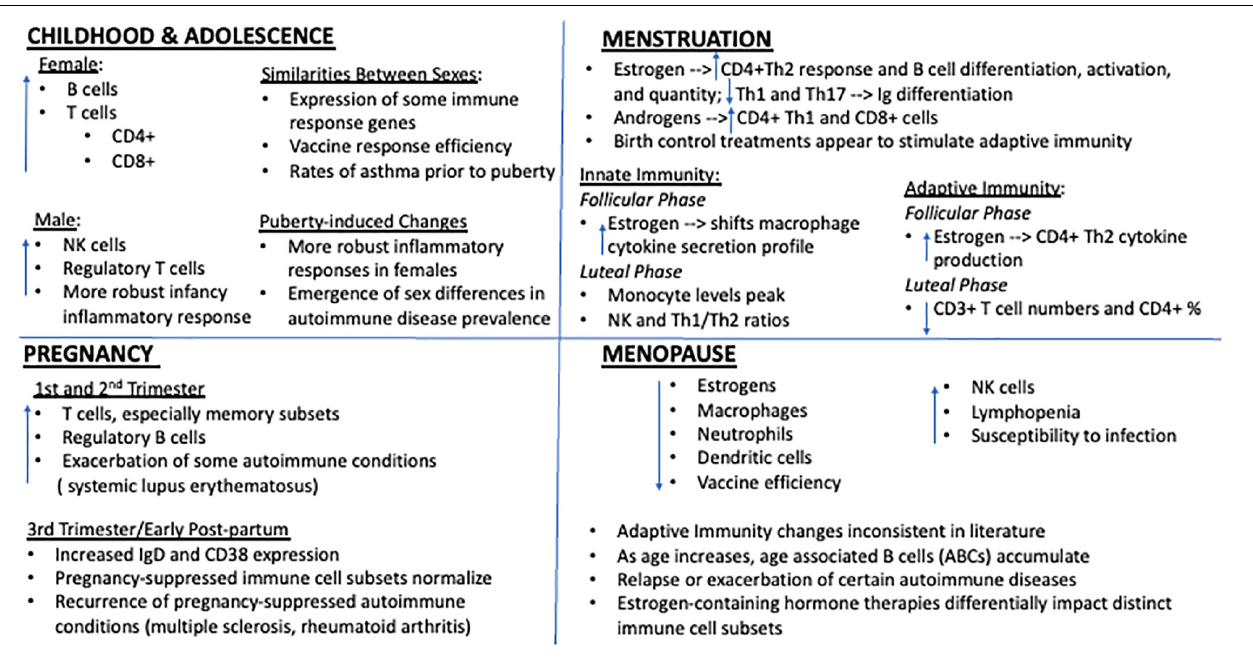
FIGURE 1 | Key immune system impacts of estrogen at distinct female reproductive milestones. Immune function is profoundly impacted by genetic sex and variations in estrogen. Though a few subtle differences have been reported during childhood, prior to puberty onset immune cell counts are generally similar between males and females and any differences appear to have little functional impact on overall immunity. However, beginning with adolescence and the onset of menstruation, marked sex differences in immune cell ratios and response profiles emerge. Generally, females display a more robust inflammatory response to immune challenge, rendering them potentially more resilient to the negative consequences of infection but also more susceptible to certain autoimmune conditions. High concentrations of estrogen, whether they be due to natural shifts in circulating levels across the cycle or via administration of estrogen containing exogenous treatments, appear to exert cell-type specific effects with regards to key immune players, generally potentiating adaptive immunity. Falling estrogen levels with the transition to reproductive and immunosenescence also imparts profound consequences for immunity and is associated with dramatic shifts in peripheral immune cell profiles, autoimmune disease manifestation, and susceptibility to immune